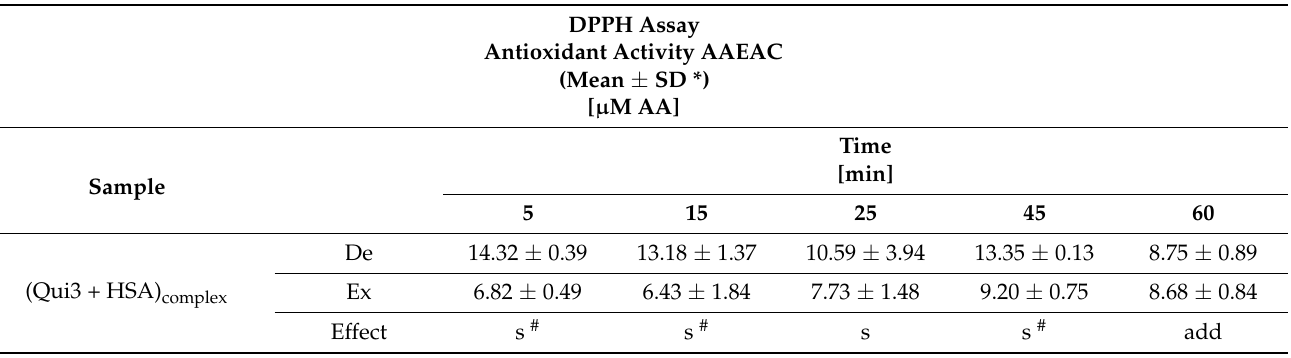
Table 7. Expected (Ex) versus designated (De) values of antioxidant activity AAEAC of the (Qui3 + HSA) complex ; DPPH